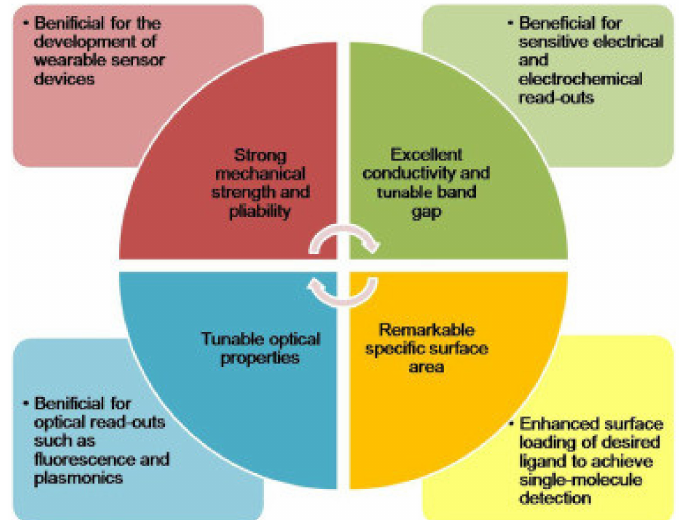
Figure 3. Chemical and physical characteristics of graphene and related materials (reprinted with permission from Ref. no. [73], Copyright 2021,